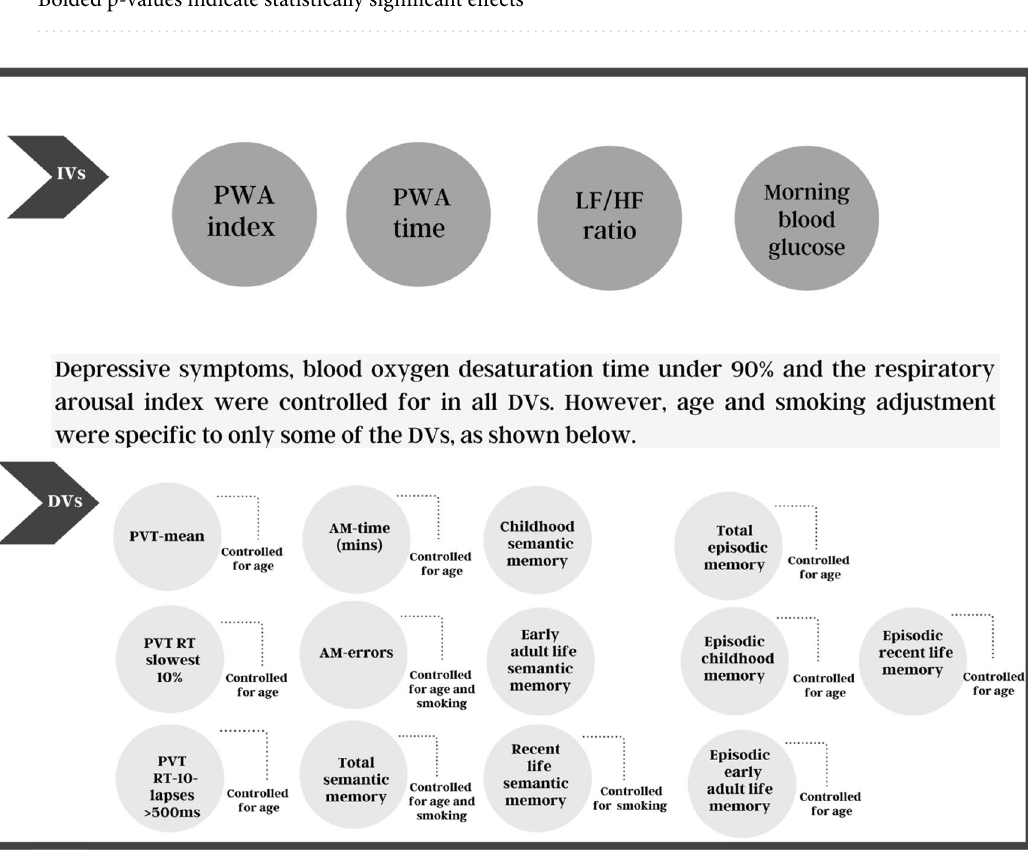
Table 4. Pearson’s correlation analysis between age, smoking, ESS and all cognitive tests. R correlation, PVT psychomotor vigilance test, RT reaction time, AM Austin Maze, ms milliseconds, ESS Epworth sleepiness scale. Bolded p-values indicate statistically significant effects